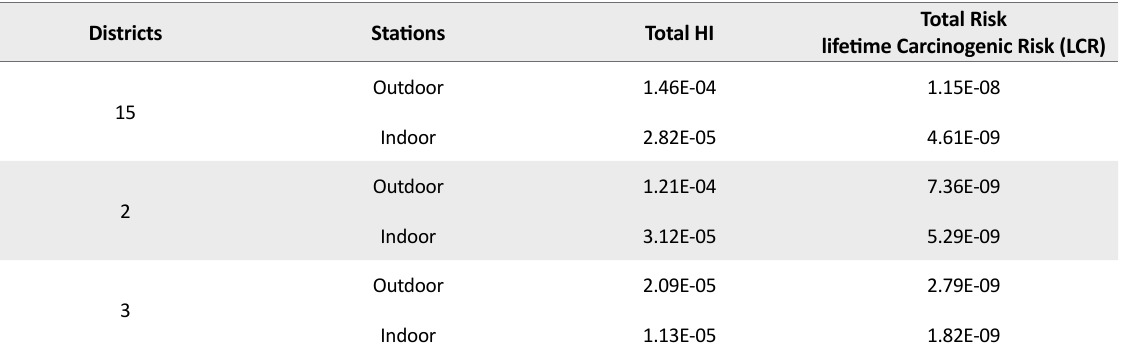
Table 3. Heavy metal carcinogenic risk and total Hazard Index (HI) in high-traffic districts of Tehran metropolis, Winter 2018 Districts Stations Total